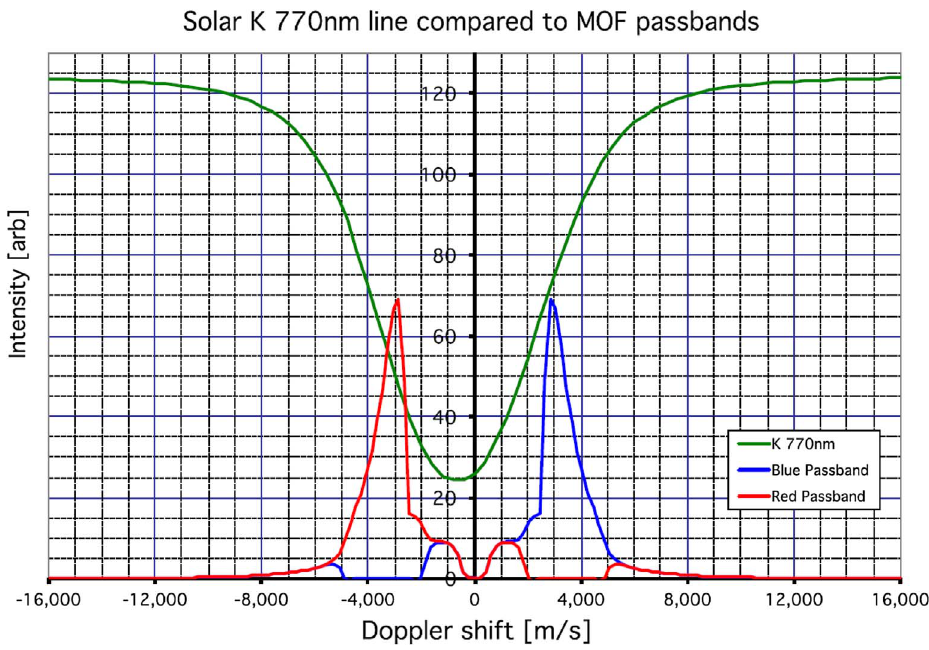
Fig. 2. Spectral response of the MOF fi lter for the K channel. Red and Blue wing spectral passbands, compared to a typical K 770 nm solar absorption line (in